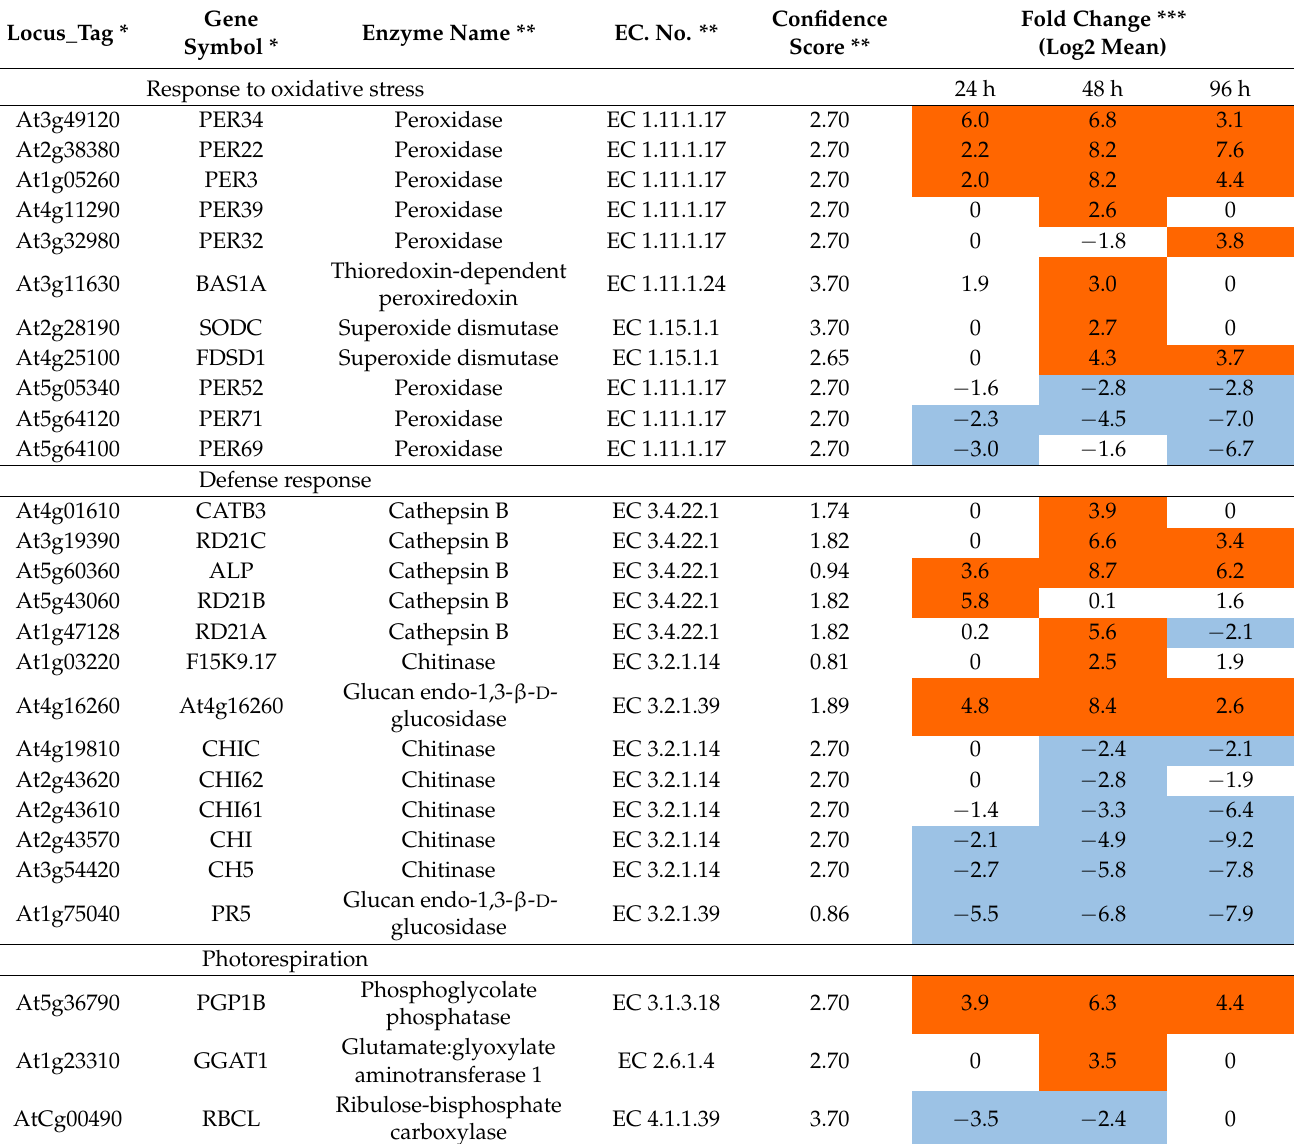
Table 2. Representative predicted enzymes differentially modulated in Arabidopsis secretome at 24, 48, and 96 of co-culture with T. atroviride